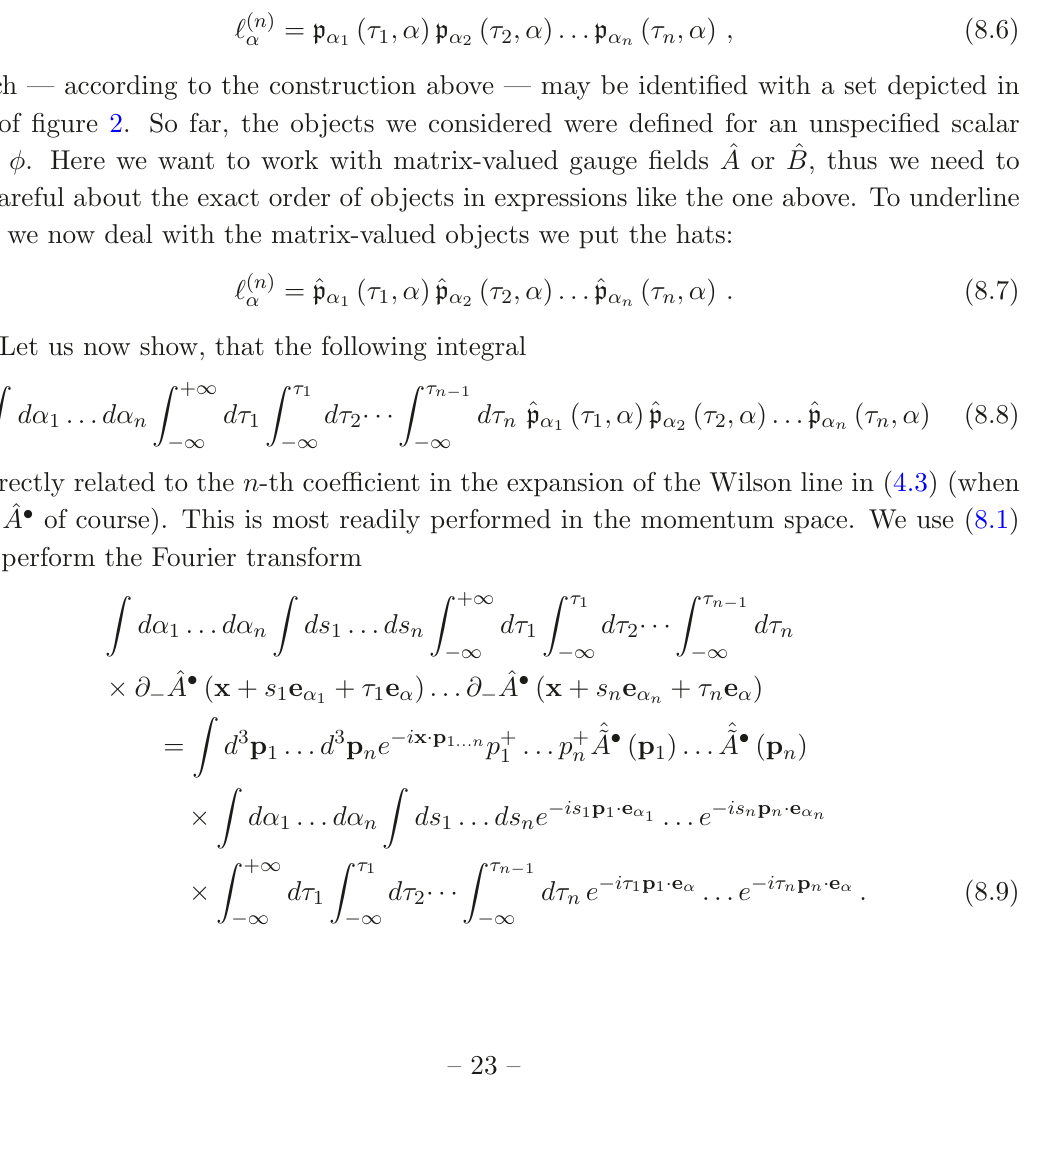
Figure 1 . Left: representation of vectors e α representation of a vector p α ( τ, α ′ ) in that